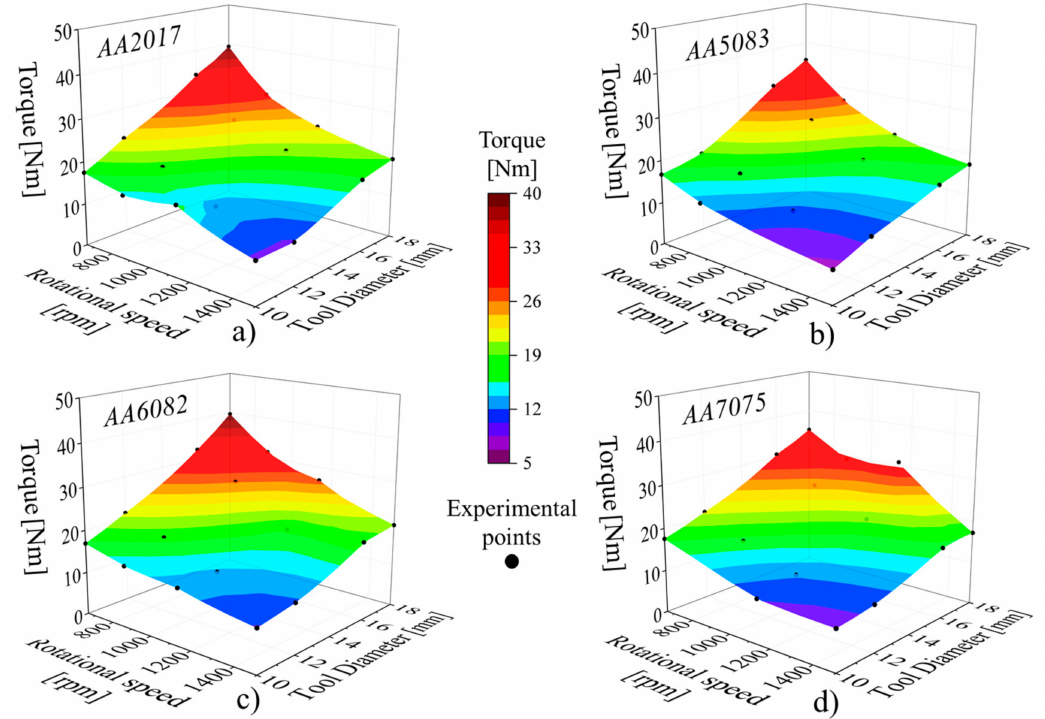
Figure 9. Evolution of torque with the rotational speed and tool diameter for the ( a ) AA2017, ( b ) AA5083, ( c ) AA6082 and ( d ) AA7075 aluminium